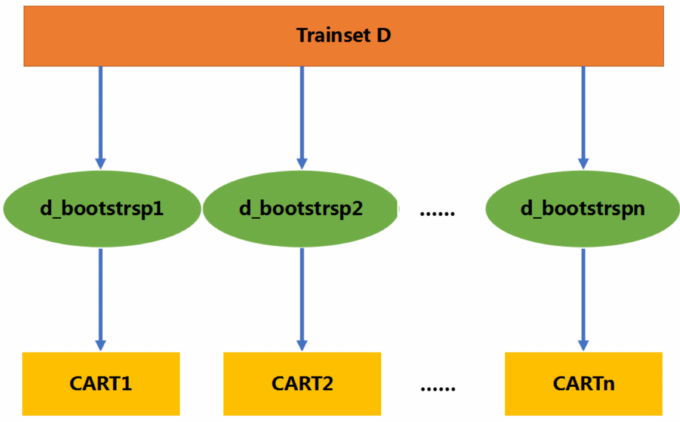
Figure 4. How the random forest regressor